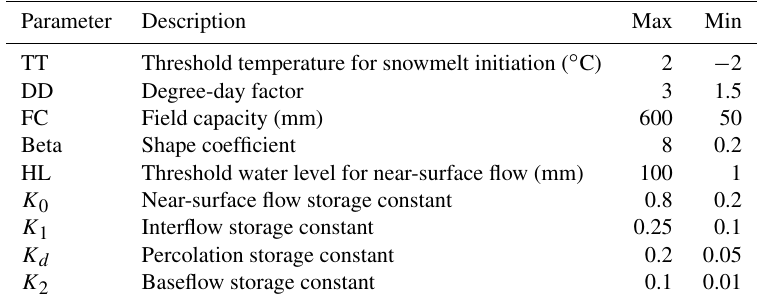
Table 2. Description of HBV model parameters and parameter ranges for model